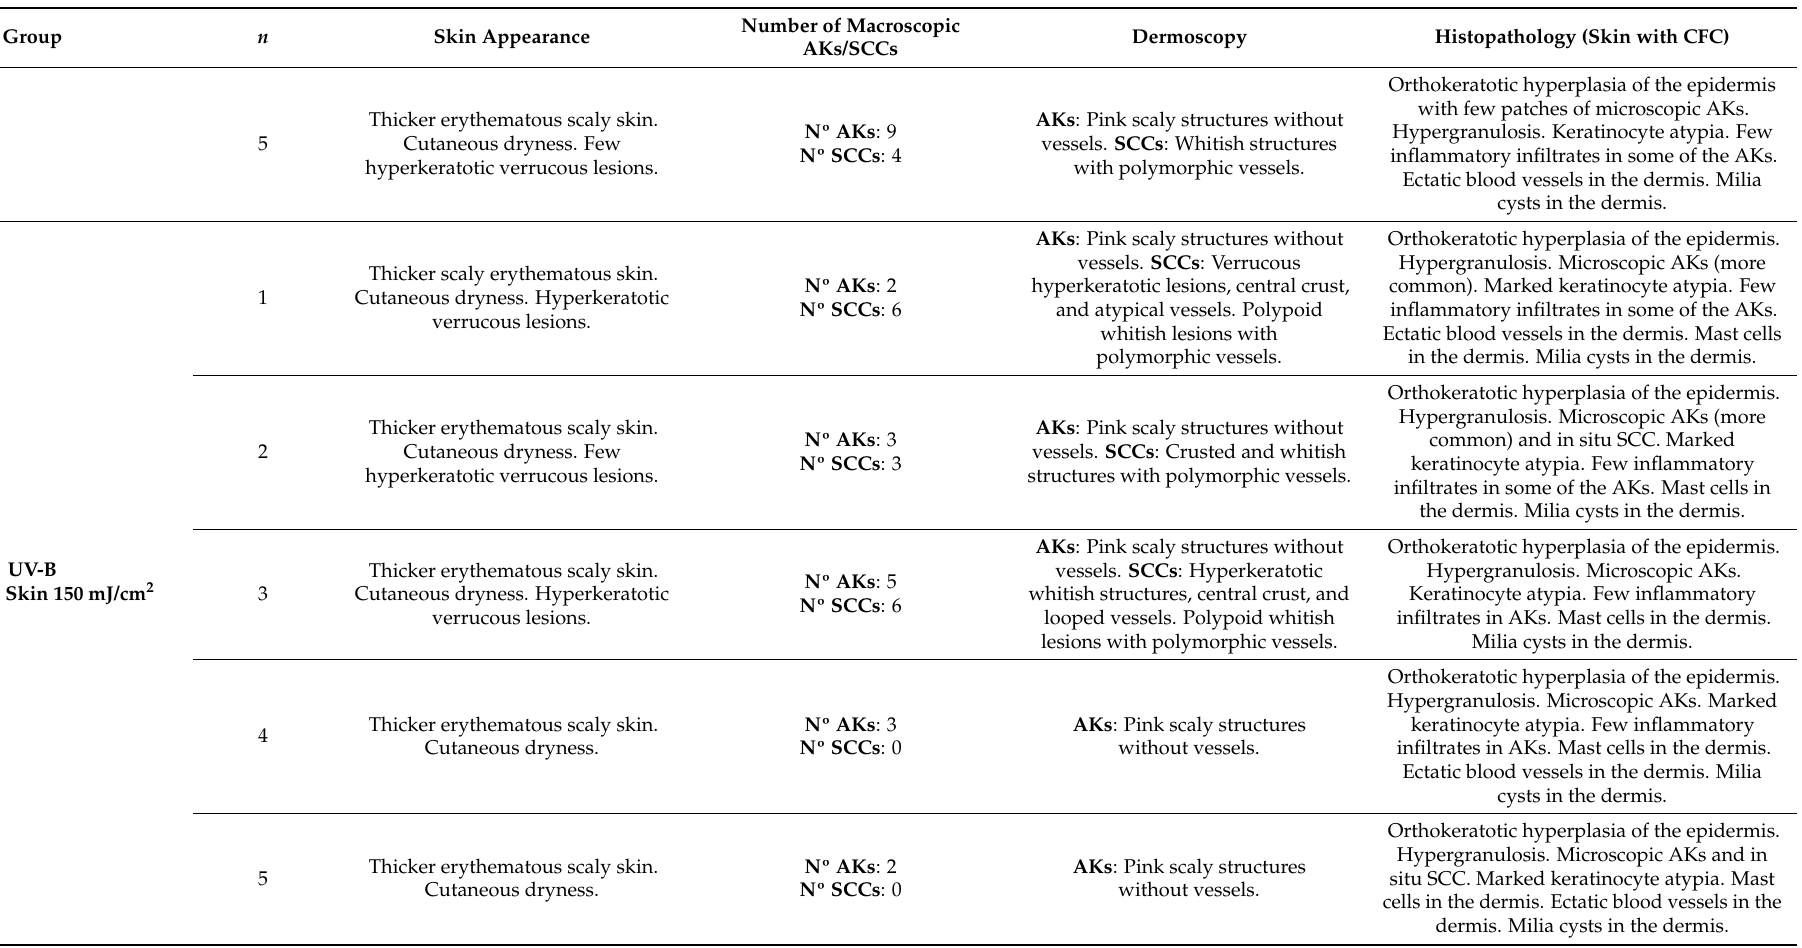
AKs : Pink scaly structures without